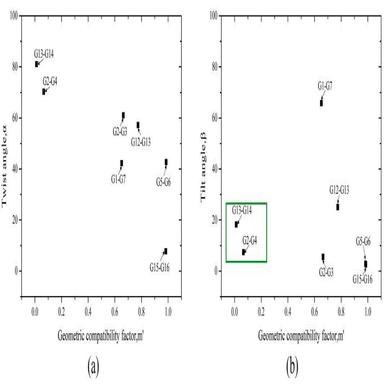
The relationship between the geometric compatibility factor m′ and (a) tilt angle α, and (b) twist angle β of slip planes in neighbouring grains.